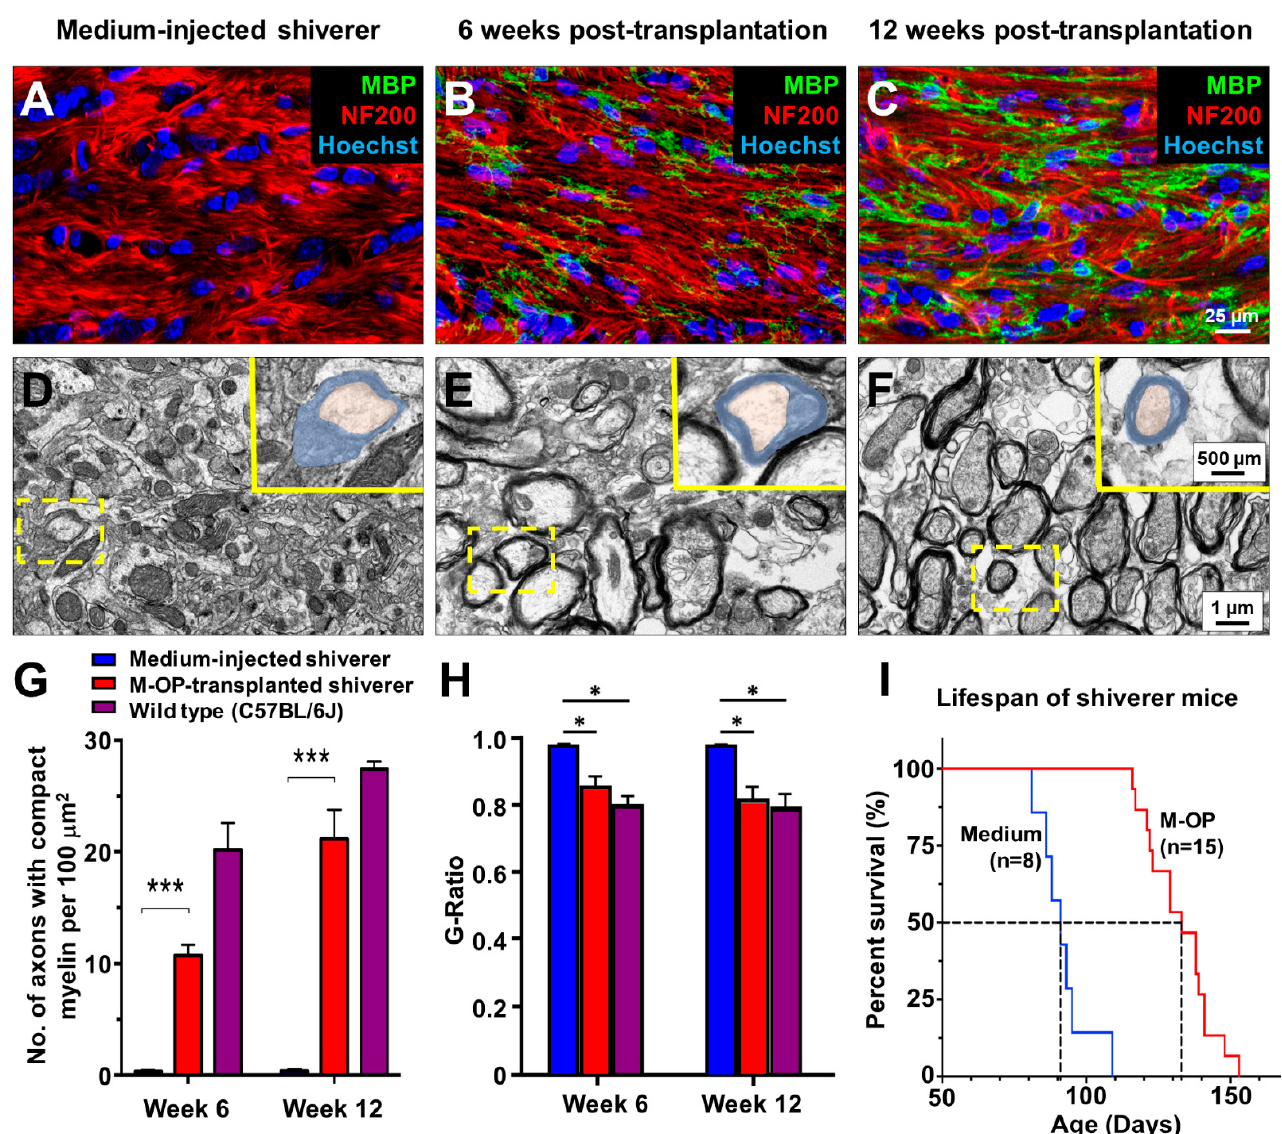
Figure 6. Compact myelin in the corpus callosum and lifespan extension of shiverer mice that received OP transplant into the corpus callosum. Medium-injected controls display no MBP-positivity in the corpus callosum ( A ). Recipients of OP transplants displayed MBP-positivity in the corpus 6 ( B ) and 12 weeks ( C ) post-transplantation. Transmission electron micrographs showing compact myelin with major dense lines in OP recipients 6- ( E ) and 12-weeks ( F ) post-transplantation, but not in the medium-injected controls ( D ) by week 12. Insets highlight OLs (blue) enwrapping axons (orange) ( D – F ). The density of axons enwrapped by compact myelin was significantly higher ( G ) with G-ratios comparable to that of wild-type mice ( H ) in OP recipients compared to controls. OP recipient shiverer mice: n = 5 (6-week) and n = 4 (12-week), control shiverer mice: n = 4 (for both time points). C57BL/6J mice: n = 4 (for both time points). The average lifespan of the OP recipients was significantly extended by 46.24% ( I ), with a median survival time of 133 days compared to 91 days in controls. *: p < 0.05, ***: p < 0.0001. Student’s t-test. Shiverer mice: n = 15 OP recipients, n = 8 medium controls.